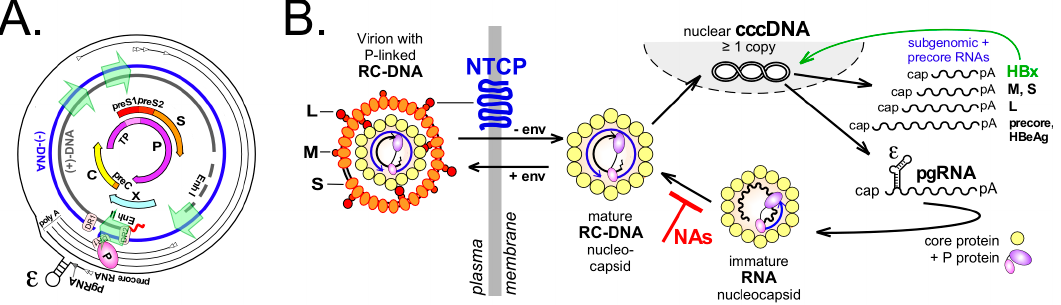
Figure 1. Molecular basics of Hepatitis B Virus (HBV). ( A ) HBV genome organization. Shown